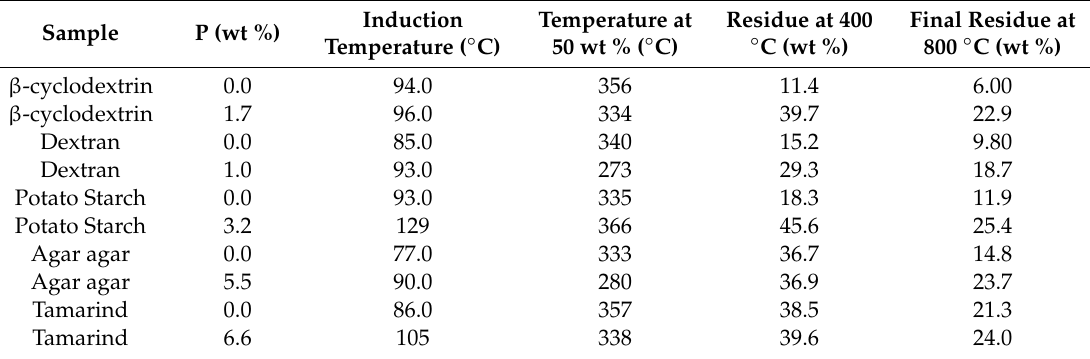
Table 2. Details from thermogravimetric analysis